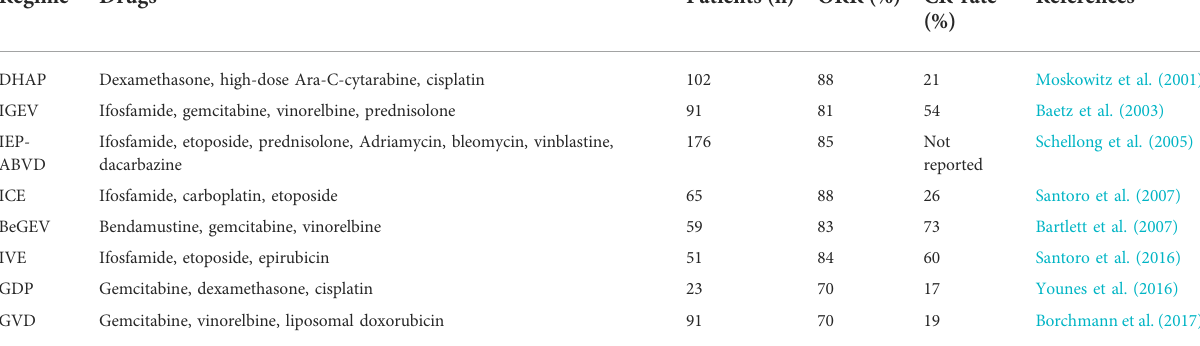
Table 5 gives a list of promising new targeted drugs. Alternative